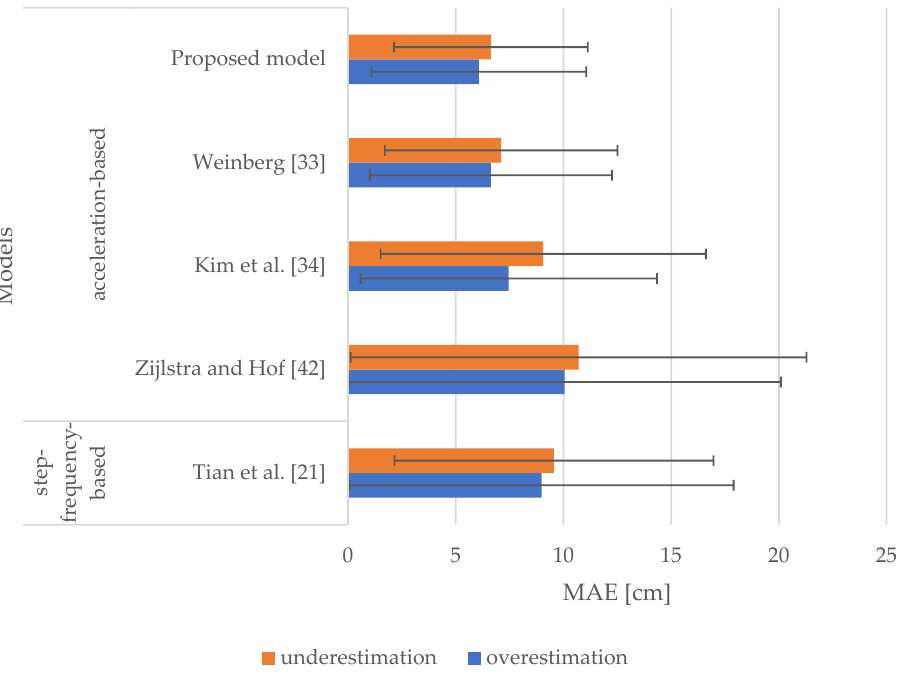
Figure 5. MAEs and SDs of overestimated and underestimated stride lengths for the selected models. Since the proposed model produced comparable results to the selected models in terms of the percentage shares, MAEs, and differences between the overestimated and underestimated stride lengths, only the overall MAEs of estimated stride lengths per sen- sor position and walking speed are listed going forward. 3.1.2. Smartphone at Upper Arm Figure 6 lays out the results achieved from the models where sensor inputs from the smartphone attached to the upper arm were analyzed. It includes MAEs and SDs of stride length estimation for slow, normal, and fast walking speeds. For slow walking speed, MAEs range from 6.20 to 8.31 cm, and the corresponding SDs vary from 4.60 to 7.16 cm. MAEs range from 6.53 to 7.86 cm and from 6.33 to 12.82 cm for normal and fast walking speeds, respectively. Furthermore, the values of SDs are in the range of 4.63 to 6.53 cm for normal walking speed and from 4.83 to 11.96 cm for fast walking speed. The proposed model produced MAEs of 6.20, 6.53, and 6.33 cm for slow, normal, and fast walking speeds, respectively. It was concluded that our proposed model generated the best results, outperforming all the models selected for comparison. These models except the model proposed by Zijlstra and Hof [42] produced MAEs greater by no more than approximately 3 cm for tested walking speeds. The model proposed by Weinberg [33] performed very similarly to the proposed model, yet it produced slightly worse results. The models pro- posed by Kim et al. [34], Zijlstra and Hof [42], and Tian et al. [21] performed the worst for fast walking speed.